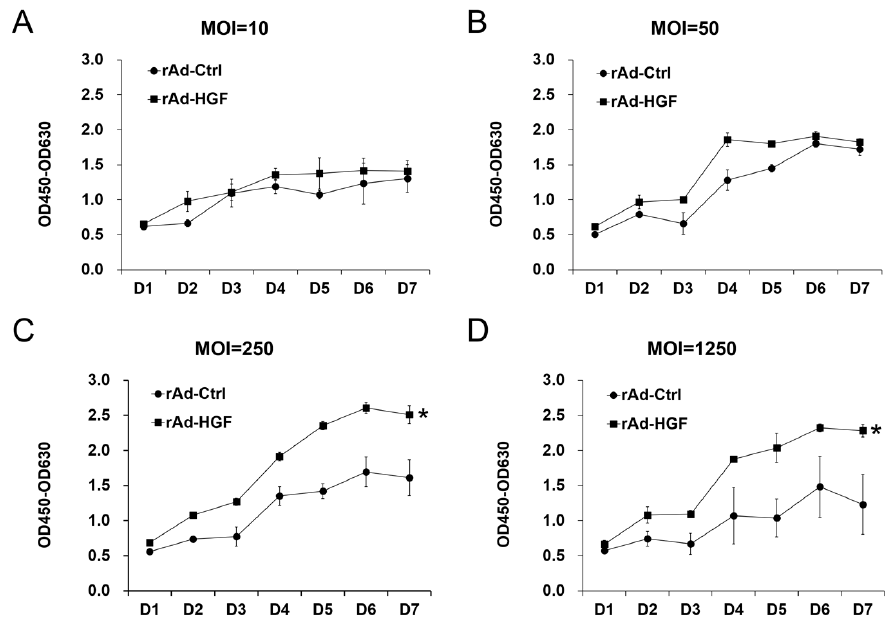
Figure 2. Effects of rAd-HGF on hBMSC proliferation. Human BMSCs were cultured in the growth medium and infected with rAd-HGF or rAd-Ctrl at MOI = 10 ( A ), 50 ( B ), 250 ( C ), and 1250 ( D ). The WST-8 method was used to evaluate the proliferation level. Infection with rAd-HGF showed significant promotive effects on hBMSC proliferation starting with MOI = 250. * p < 0.05. The experiment has been replicated four times with similar results, and the representative results were